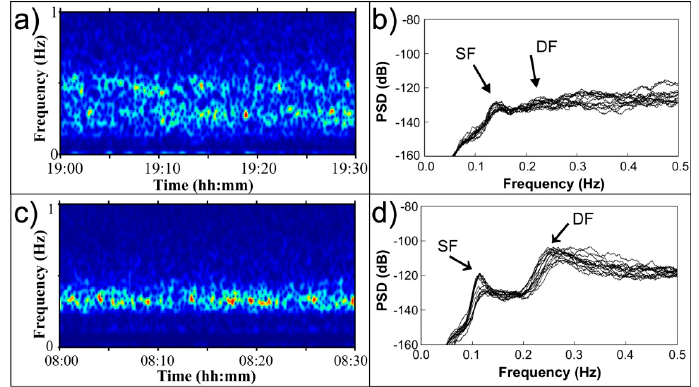
Figure 6. ( a ) Spectrogram for a 30-minute time window (vertical grey stripe in Figure 4a) for volcanic tremor recorded between 7:00 and 7:30 p.m. GMT during a lava fountain episode. Red, yellow, and green colours define the dominant spectral amplitudes; light to dark blue colours define lower amplitudes and background. The spectrogram shows a variable low-frequency content in the 0.1–1 Hz frequency band. ( b ) Power Spectral Density (PSD) computed for 14 30-minute segments (Z component of the seismometer), zoomed in on the frequency band 0–0.5 Hz. Single Frequency (SF) and Double Frequency (DF) peaks are not evident. ( c ) Spectrogram for a 30-minute time window (vertical grey stripe in Figure 4b) for oceanographic noise recorded between 8:00 and 8:30 a.m. GMT. A near-monochromatic frequency around 0.3 Hz is visible; it is consistent with the DF peak. ( d ) PSD computed on 14 30-minute segments (Z component of the seismometer), zoomed in on the frequency band 0–0.5 Hz. The two frequency peaks related to microseisms (~0.1 and ~0.3 Hz) are visible. A more detailed spectral analysis of both oceanographic noise and volcanic tremor signals was performed on the 0.0 – 0.5 Hz frequency band (Figures 6b,d) on 14 30-minute segments. The volcanic tremor showed a rough frequency peak close to 0.1 Hz, whereas spectral amplitudes remained almost constant at frequencies ranging between 0.2 and 0.5 Hz (Figure 6b). Spectra computed on oceanographic noise (Figure 6d) show the two peaks at frequencies close to 0.1 and 0.3 Hz. These frequencies correspond to the two typical microseismic peaks caused by ocean wave energy coupling into the motion of the earth: the Single Frequency (SF) peak ( ∼ 0.1 Hz) and the much stronger Double Frequency (DF) peak ( ∼ 0.3 Hz) [25]. The SF peak is generated by direct ocean wave pressure fluctuations at the ocean bottom; the amplitude of wave-induced pressure fluctuations decreases exponentially with depth from the sea surface depending on the bathymetry. The DF peak is produced by the interaction of sea gravity waves with the seafloor [19,25]. The SF peak has been associated with high-amplitude storm waves impacting long stretches of coastline nearly simultaneously, whereas the DF peak is related to wind speed and direction, implying that the energy reaching the ocean floor is generated locally by ocean gravity waves [52]. In the Ionian Sea, the SF peak is considered characteristic of deep-sea monitoring sites that are not too far from the coastlines, which is more easily observed during favourable weather conditions. The presence of the energetic DF peak suggests the influence of local winds [53]. Although spectra of oceanographic noise showed well-defined SF and DF peaks (Figure 6d), in the volcanic tremor signal spectra, the SF peaks are not clearly delineated (Figure 6b). The spectral amplitudes of SF and DF peaks computed for the volcanic tremor signal were both about − 130 dB, whereas the SF and DF peaks of oceanographic noise signal had more pronounced spectral amplitudes (about − 120 dB and − 90 dB,